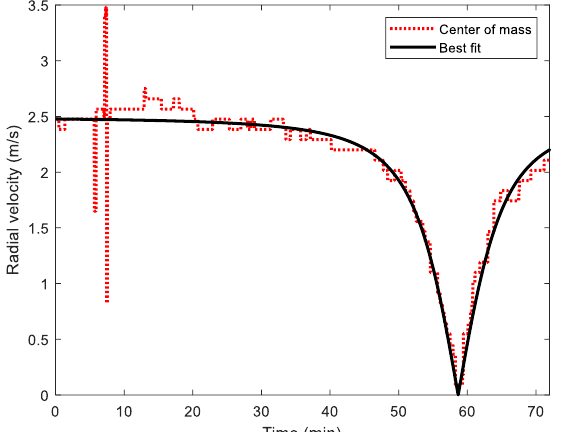
Figure 12. Estimated radial velocity from Figure 11 and best fit to the model given in Equation (1).